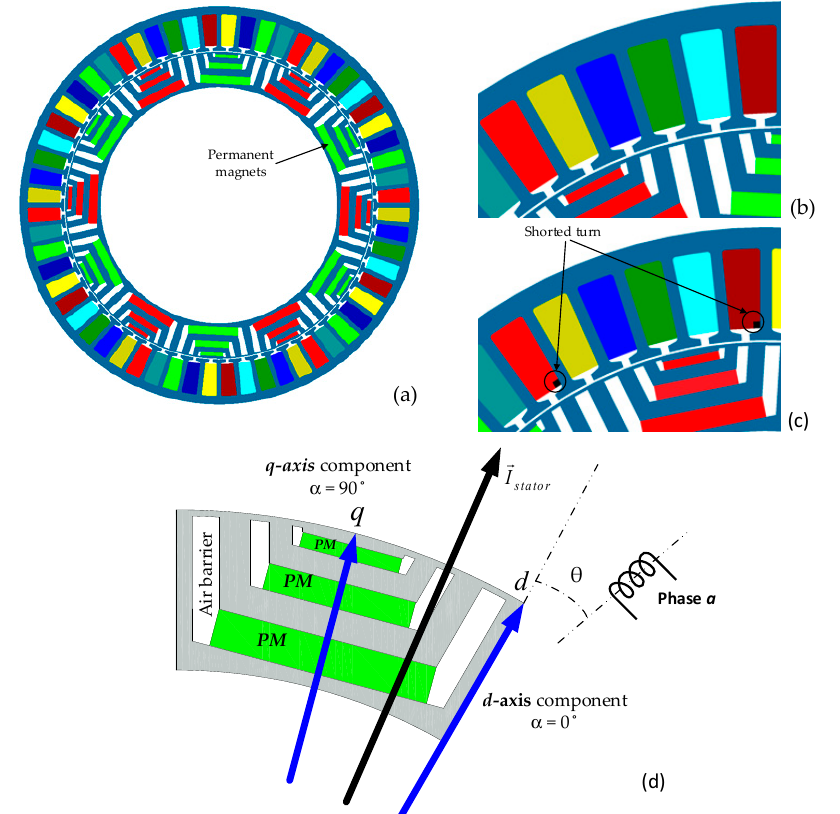
Figure 1. Finite element method (FEM) models of the fPMa-SynRM studied in this paper. ( a ) Stator and rotor layouts. ( b ) Healthy winding. ( c ) Faulty winding detailing the shorted turn. ( d ) d - and q -axis components of the stator current and angle θ between the actual rotor position ( d -axis) and reference phase a .